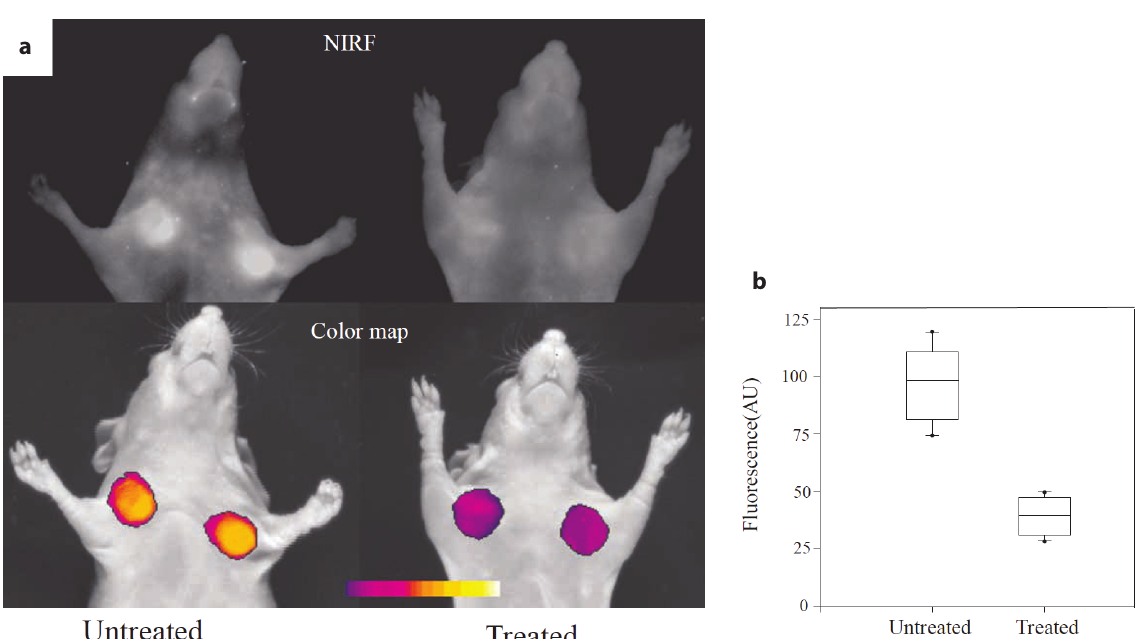
Figure 2. In vivo planar imaging of an activatable probe. ( a ), In vivo NIR fluorescence imaging of HT1080 tumor-bearing animals. The top row shows raw image acquisition obtained at 700 nm emission. Untreated (left), treated with 150 mg/kg prinomastat, twice a day, i.p. for 2 d (right). The bottom row shows color-coded tumoral maps of MMP-2 activity superimposed onto white-light images (no treatment (left), prinomastat treatment (right)). ( b ), Quantitative image analysis of all 20 tumors. Tumoral NIR fluorescence signals are shown in a box plot (bars indicate 10 th and 90 th percentile). The difference in imaging signal between the two groups was statistically significant (P < 0.0001) (Adapted from [38]; reprinted with